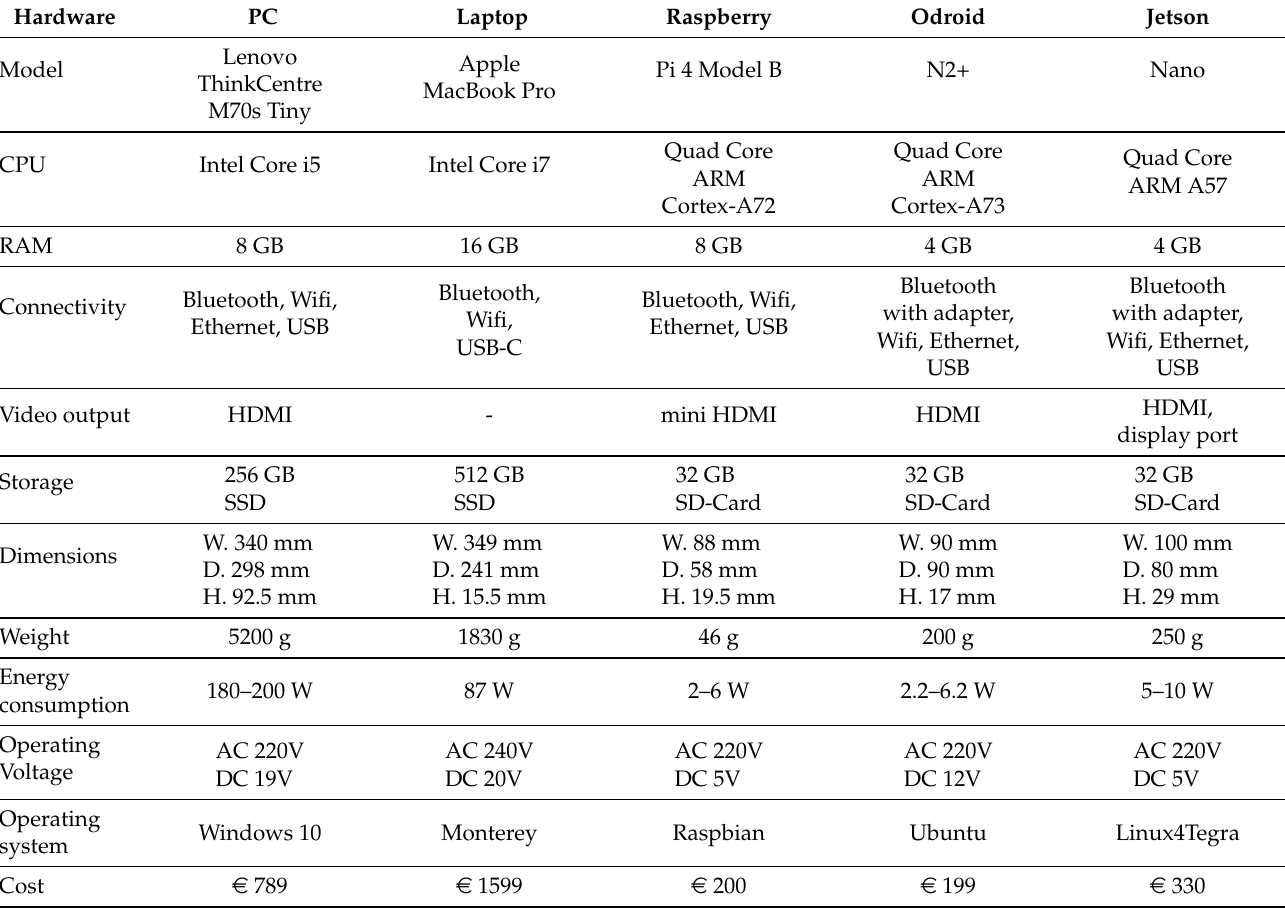
Table 1. Comparison of the PC, Laptop, and ARM-based-embedded units.